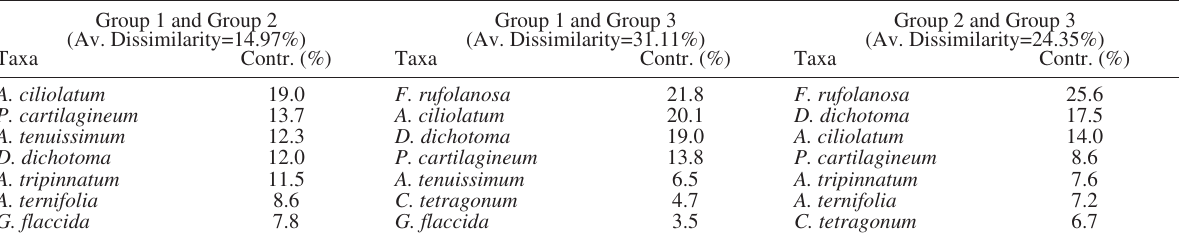
Table 4. – Summary of SIMPER procedure indicating the dissimilarity between Group 1 (N; 3 m), Group 2 (N; 7 m) and Group 3 (NW), and the contribution (%) of each taxon.